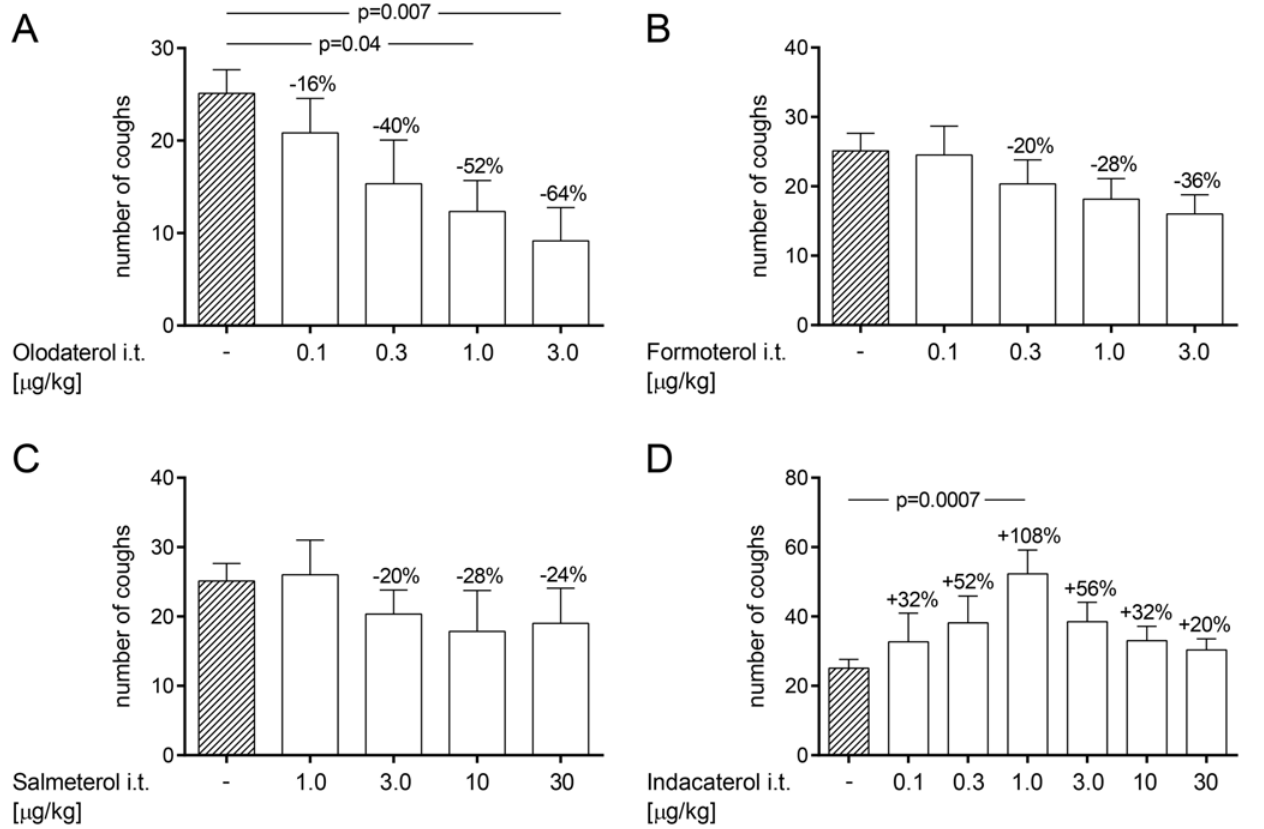
Fig 4. Effect of dry powder administration of β 2 -agonists on citric acid-induced cough in OVA-sensitized guinea pigs.